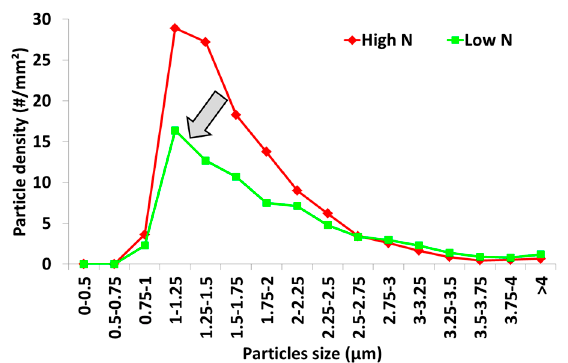
Figure 12. TiN particle size distribution for the high N and low N steel (SEM analysis: chemical composition measured by EDX, size measured by automated procedure based on image contrast).